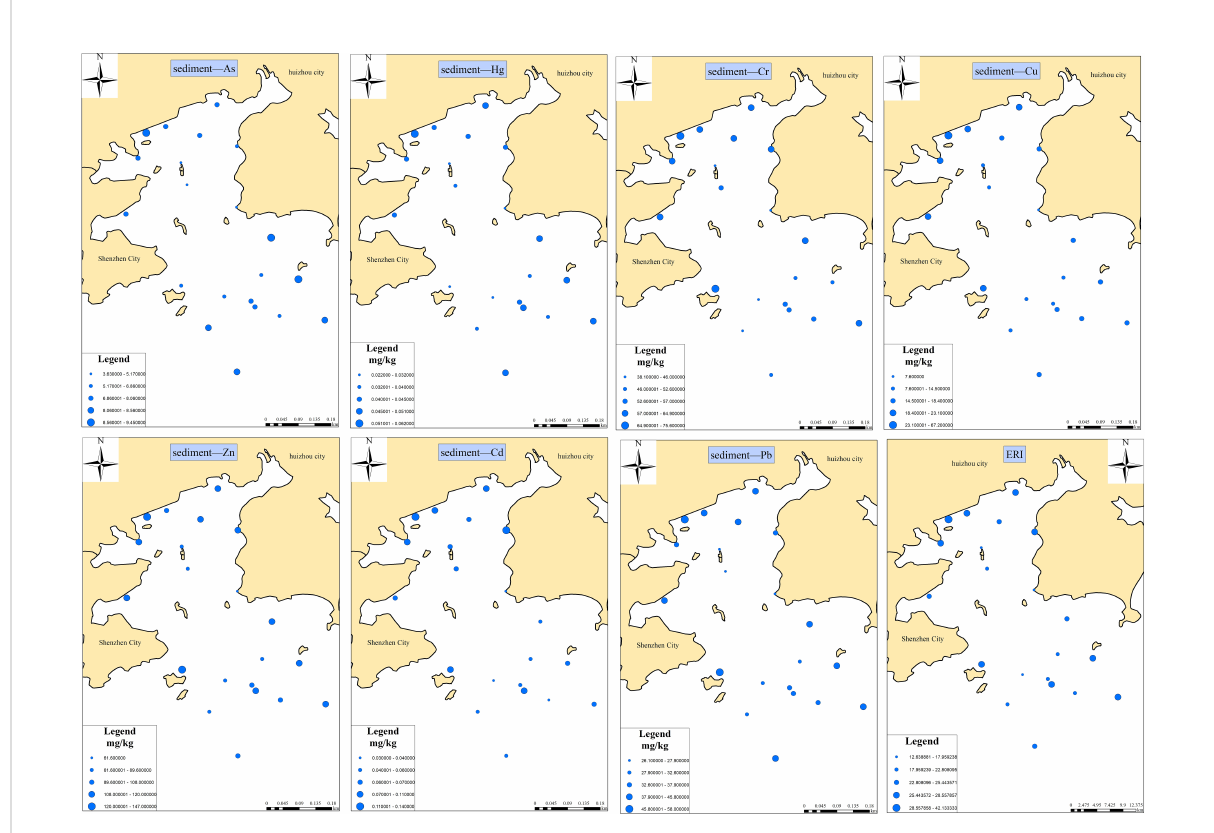
FIGURE 4 Change trend of heavy metals in seawater from 2015 to